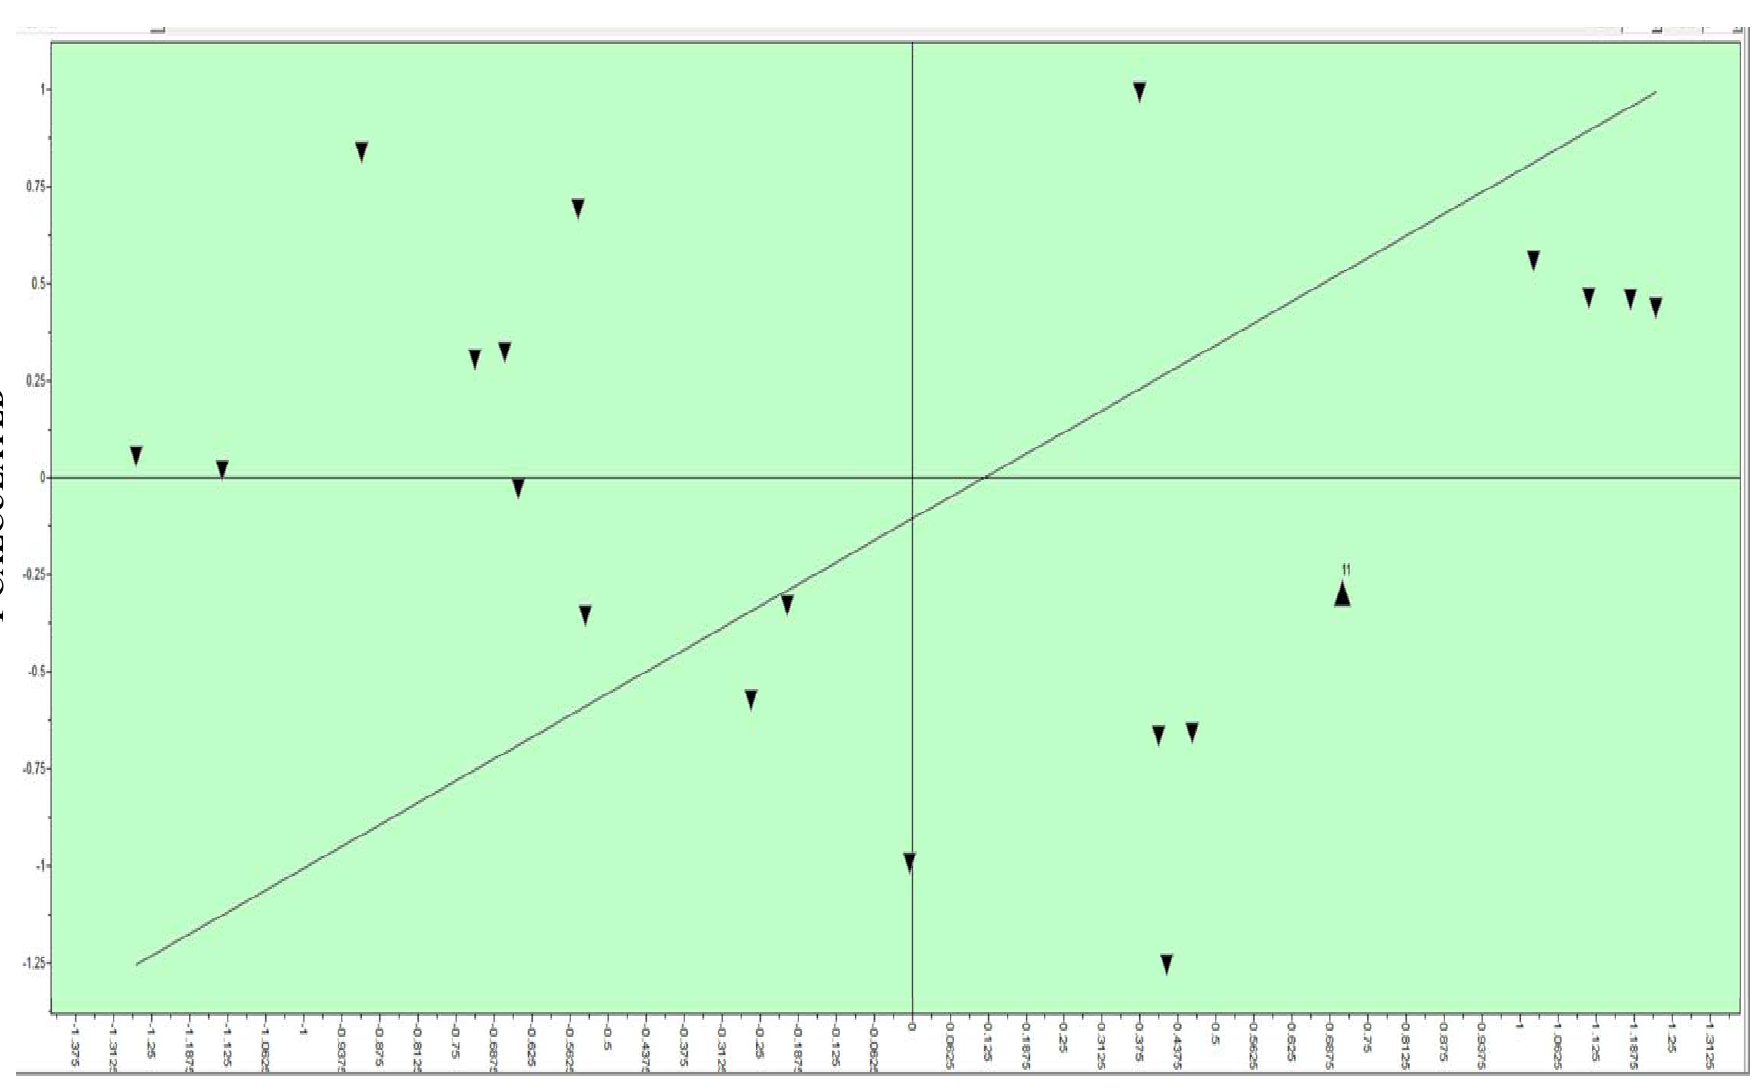
Figure 7. Best fit model obtained in